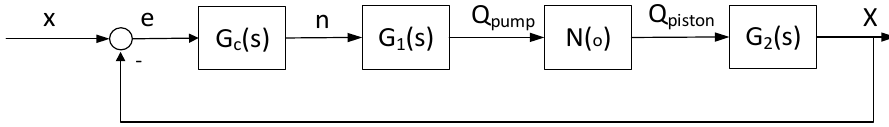
( ) G s is the transfer 1